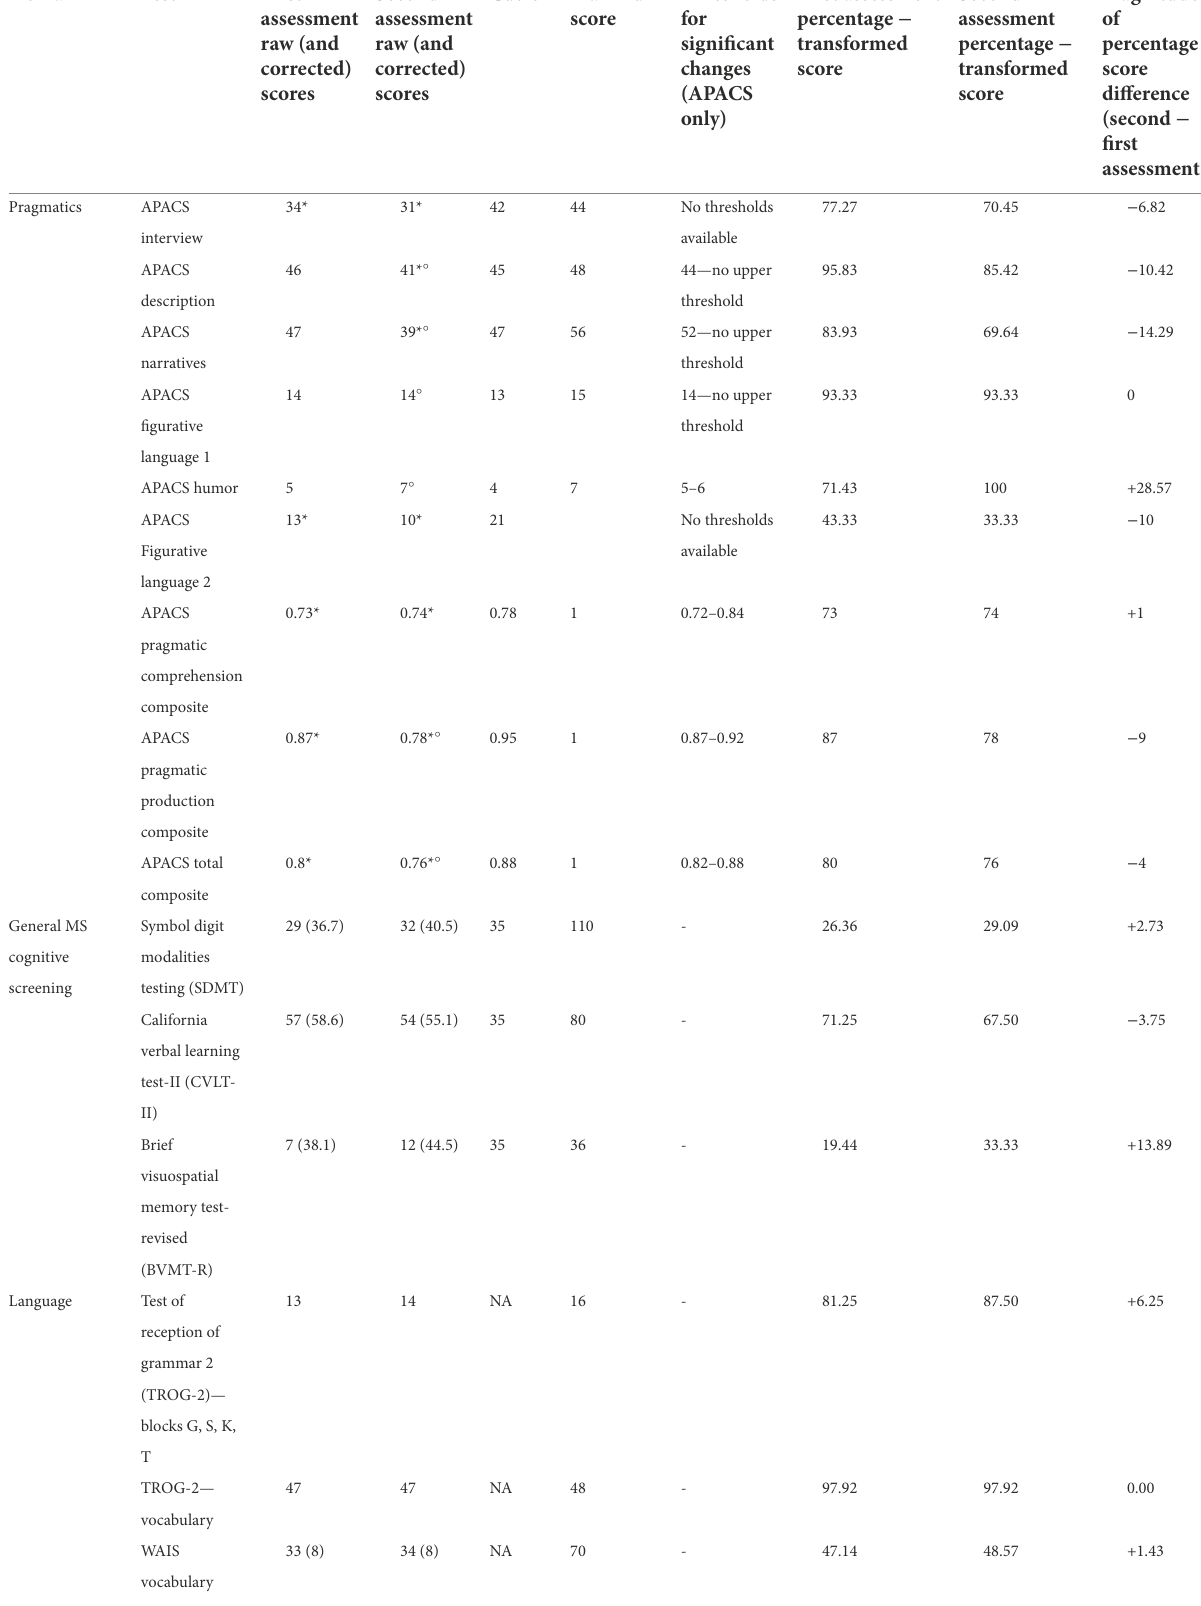
TABLE 1 Neuropsychological